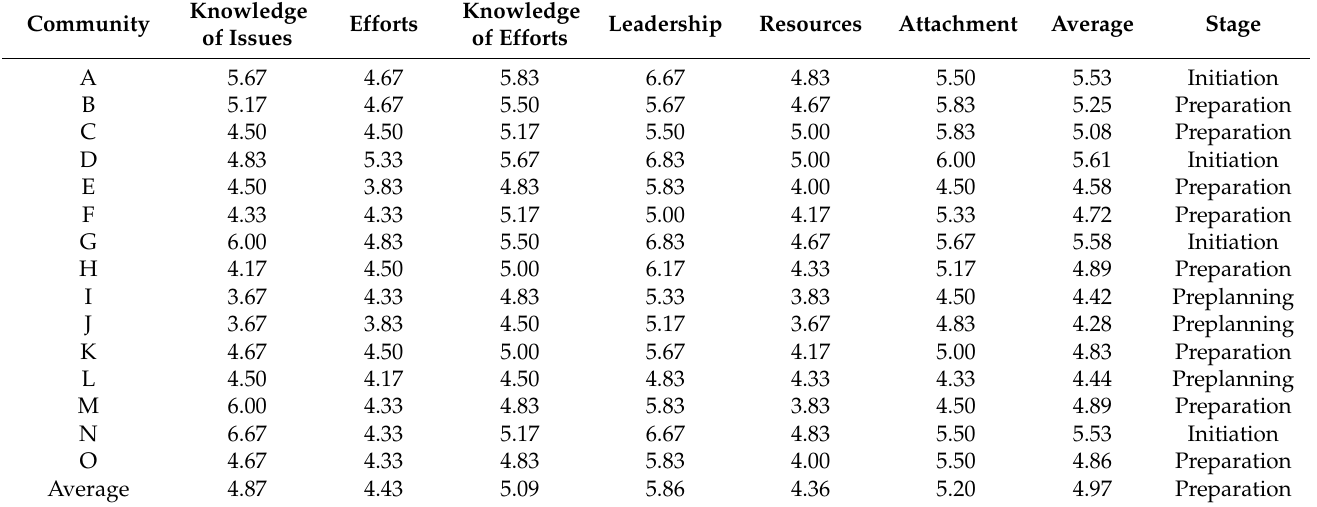
Table 4. Community readiness